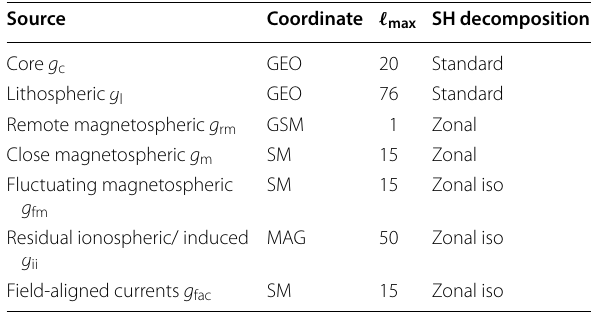
Table 1 Magnetic sources considered in the model